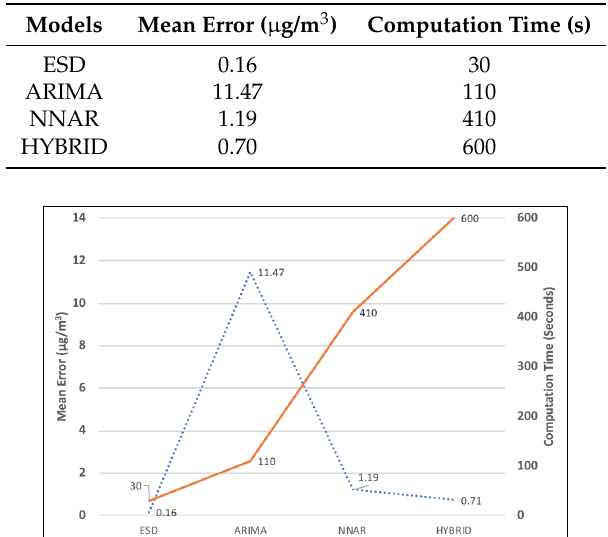
Table 1. Comparative analysis with baseline models.